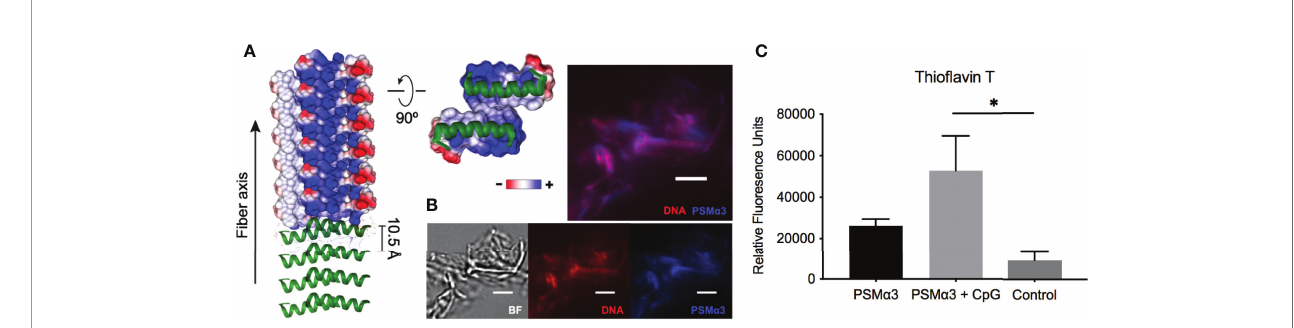
FIGURE 2 | DNA promotes PSM fi brillation via direct association. (A) Crystal structure of PSM a 3 fi ber (PDB: 5I55) with electric potentials of charge residues projected on surface model. The electric potentials were calculated using Chimera software. (B) Fluorescence staining of PSM a 3-DNA complexes using nucleic acid dye BOBO-3 iodine (red) and Thio fl avin T, which only binds to fi brillar amyloid structures. Scale bar: 3 m m. (C) Fibrillization of synthetic PSM a 3 with or without CpG DNA was monitored by Thio fl avin T fl uorescence and reported as relative fl uorescent units (RFU). Mean and SEM graphed; signi fi cance was calculated using One- way ANOVA with Tukey ’ s multiple comparisons test (*, P